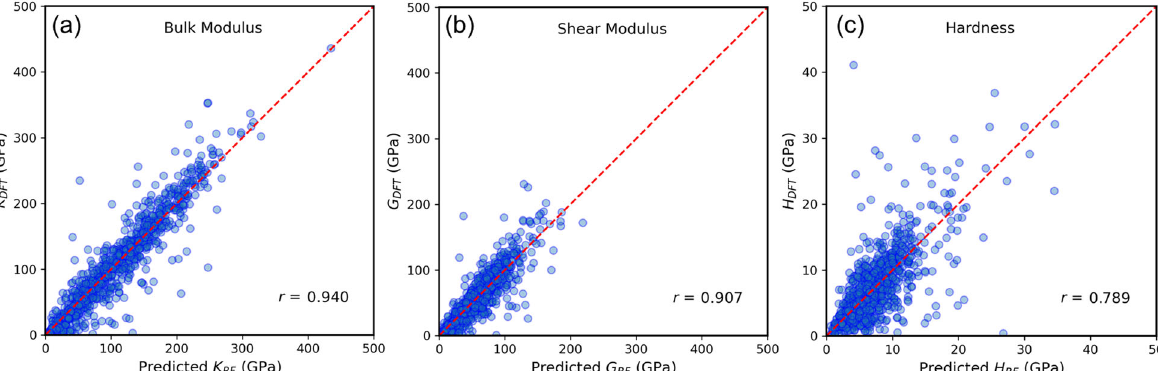
Fig. 3 Evaluation of the random forests (RF) models. The Pearson correlation coef fi cient ( r ) is utilized as a metric for a bulk modulus ( K ), b shear modulus ( G ), and c hardness ( H ). The machine learning models are trained to predict, respectively, K and G , and both can achieve r > 0.9 when applied to the test set based on density functional theory (DFT) calculations. H DFT is computed using K DFT and G DFT with Tian ’ s empirical formula. The predicted hardness H RF is also obtained by Tian ’ s formula with K RF and G RF as inputs, which results in an inferior correlation coef fi cient as